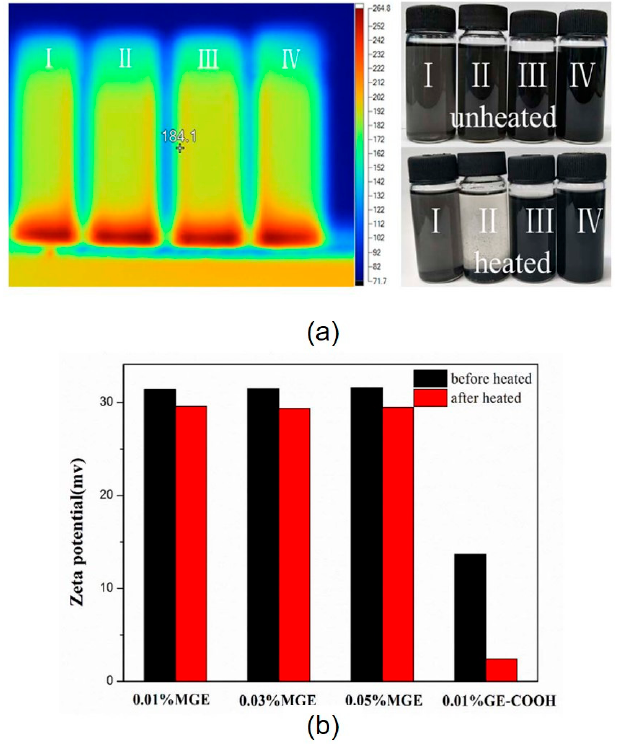
Figure 19. ( a ) Infrared thermography and photographs and ( b ) zeta potentials of nanofluids before and after being kept at 180 °C for one month [67]; 2017, Elsevier.